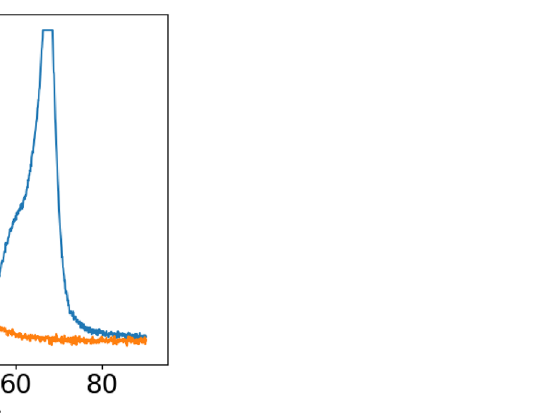
Figure 7. The required relations for the calculation of the proton flight time, kinetic energy spectrum and beam propagation for the two beamline operation modes (low dose per pulse (LD) and high dose per pulse (HD)). ( a ) The measured proton flight time reference produced by the 800 nm laser light and the calculated 370nm proton flight time reference considering the dispersion in the fiber. The uncertainty of time of the potodiode detector of 150 ps. ( b ) The energy loss of the protons in the scatterers, the Kapton window and the air distance depending on their initial kinetic energy. ( c ) The simulated relation between the flight time and the kinetic proton energy at the position of the time-of-flight (ToF) beam monitoring system (BMS). ( d ) The simulated kinetic proton energy uncertainty of the ToF BMS dependent on the proton energy at ToF BMS position. ( e ) The deposited energy in the scintillator dependent on the proton energy at ToF BMS position. ( f ) The proton beam divergence and profile. f 1 ) The energy-resolved proton beam divergence at ToF BMS position with and without ToF aperture for LD and HD operation mode. f 2 ) The proton beam profile (red channel of scanned RCF image) at Ap3 position for the LD operation and proton energies beam profile (green channel of scanned RCF image) at Ap2 position for the HD operation and proton energies 23.7 MeV . ≥